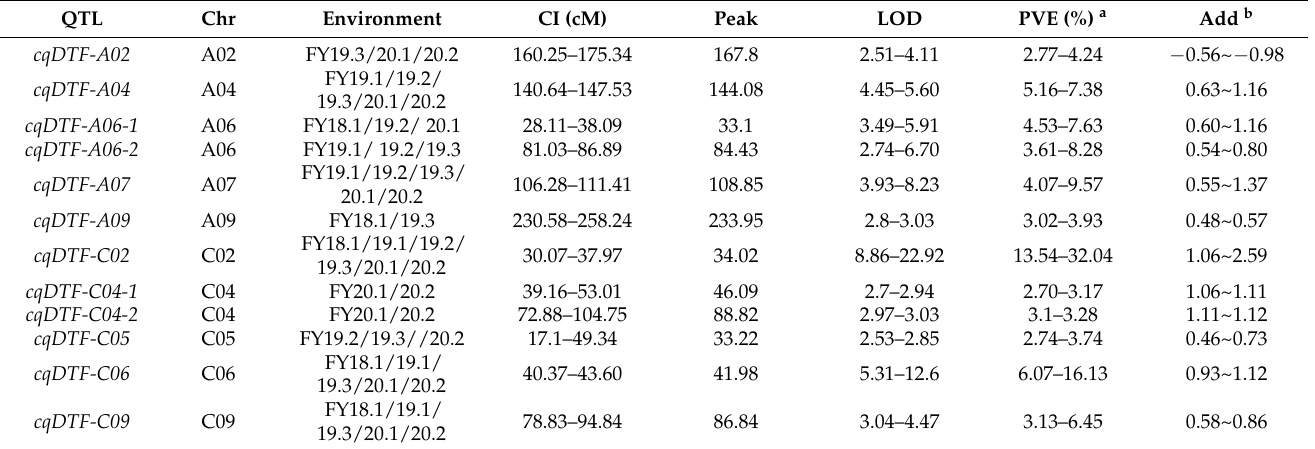
Table 2. Consensus QTLs for DTF identified by meta-analysis in the 158A-SGDH population.